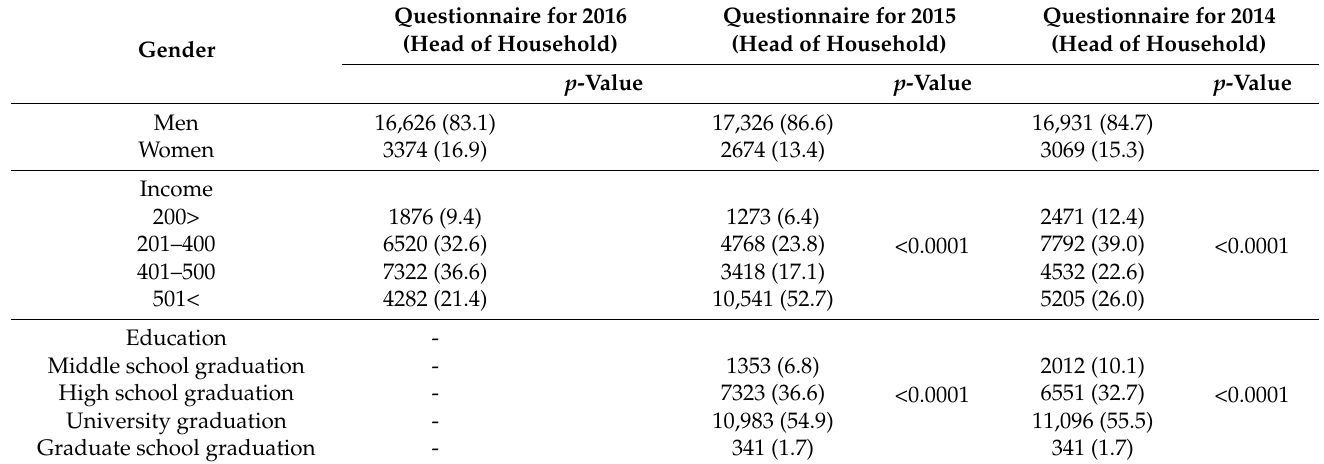
Table 1. Gender, income, and education levels of surveys respondents in Seoul.